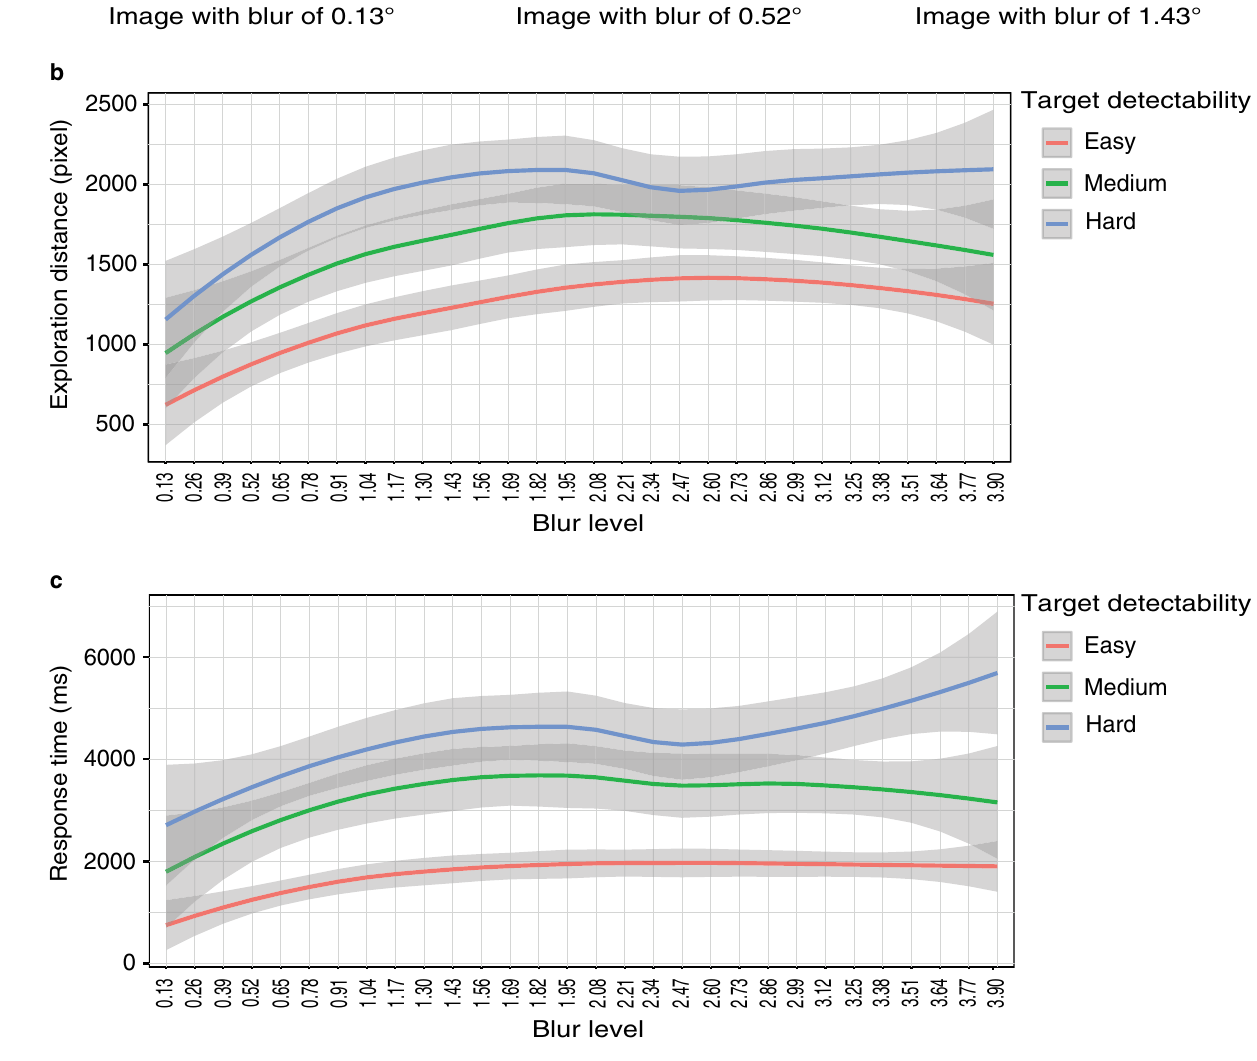
Figure 5. The stimuli and results of the Experiment 3a. ( a ) The same image superimposed by three different levels of blur. ( b , c ) Show how exploration distance and response time change along with the blur